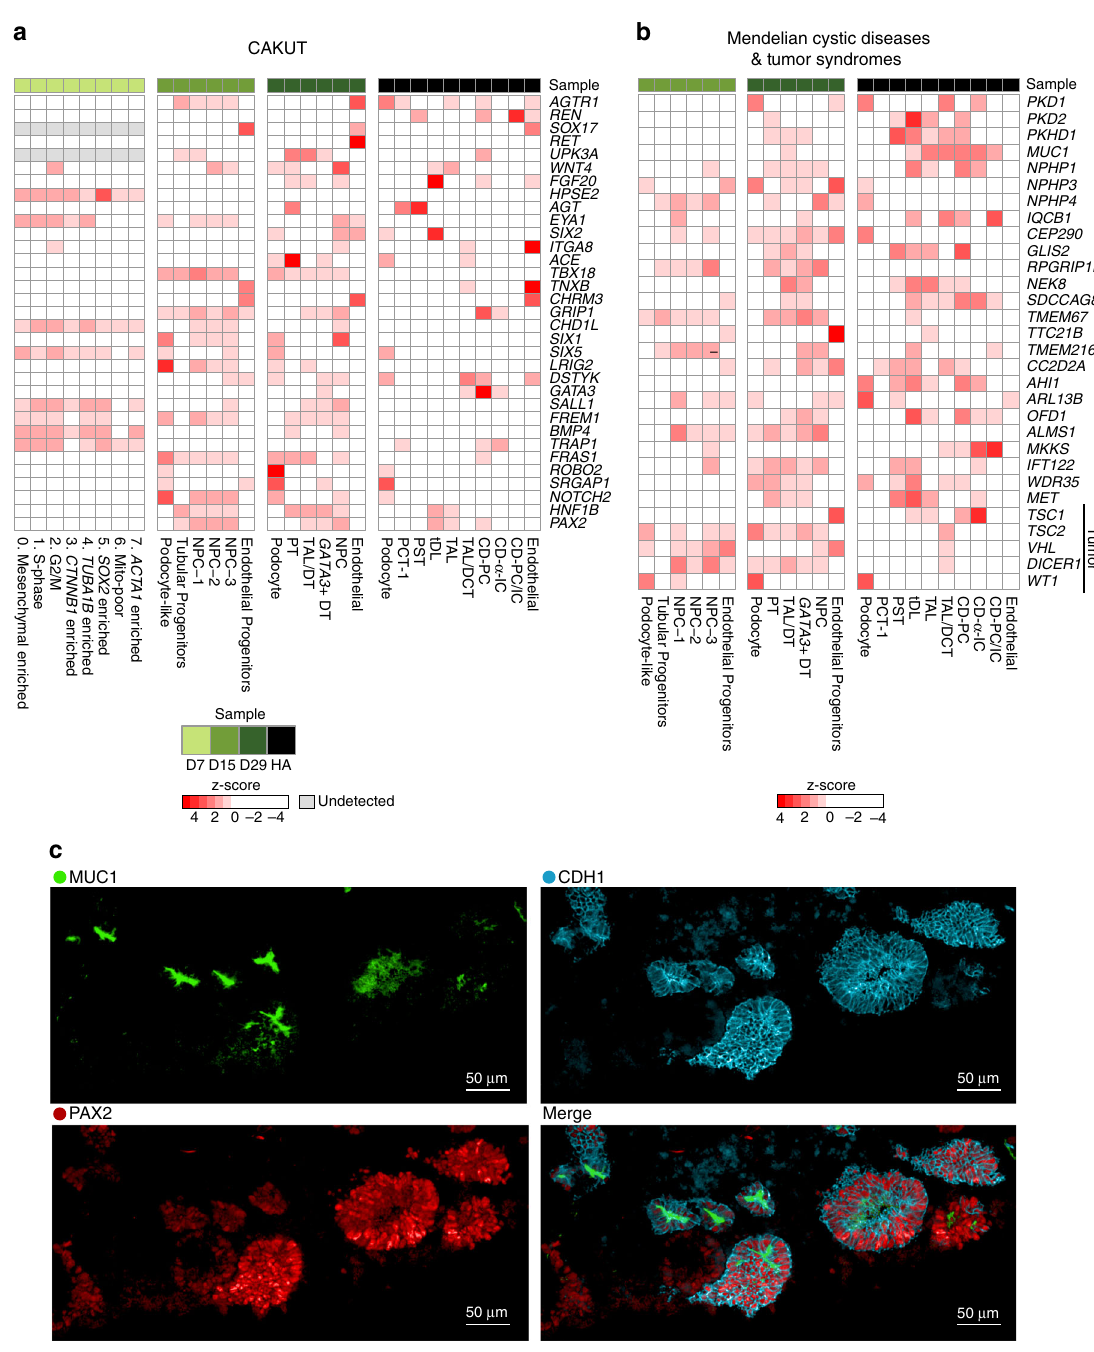
Fig. 5 Genes associated with kidney diseases are expressed in expected compartments across organoids from four human iPSC lines. Heatmap of cell-type- speci fi c gene expression (ThF line, ML protocol) in organoids and human adult kidney. Genes implicated in monogenic causes of a congenital abnormalities of the kidney and urinary tract (CAKUT), and b mendelian renal cystic diseases and tumor syndromes. c IF staining validates the expression of MUC1 and PAX2 in the distal tubule in D29 kidney organoids. CDH1 serves a distal tubular marker. Note appropriate apical expression of MUC1 in distal tubular epithelial